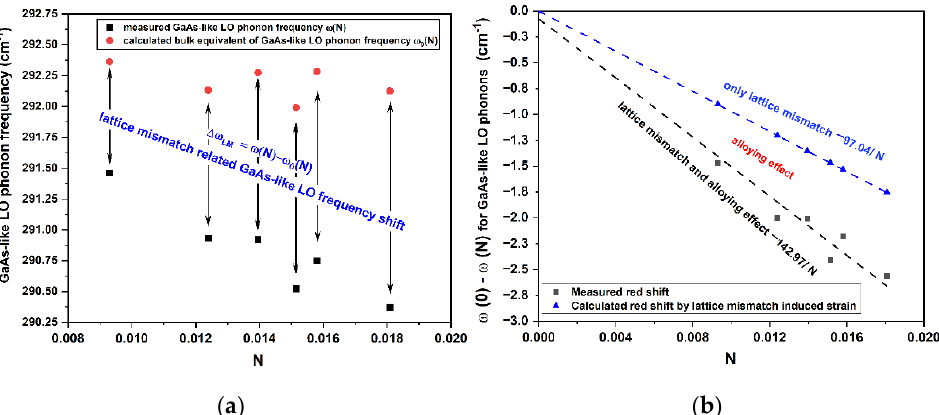
Figure 5. Determined from Raman spectra, two dependencies on N content: ( a ) GaAs-like LO frequencies of strained GaAsN epilayers (black squares) and calculated bulk GaAsN equivalent frequencies (red circles); ( b ) the experimental redshift of the GaAs-like LO phonons frequencies (black squares) with the estimated influence of strain induced by a lattice mismatch (blue triangles).